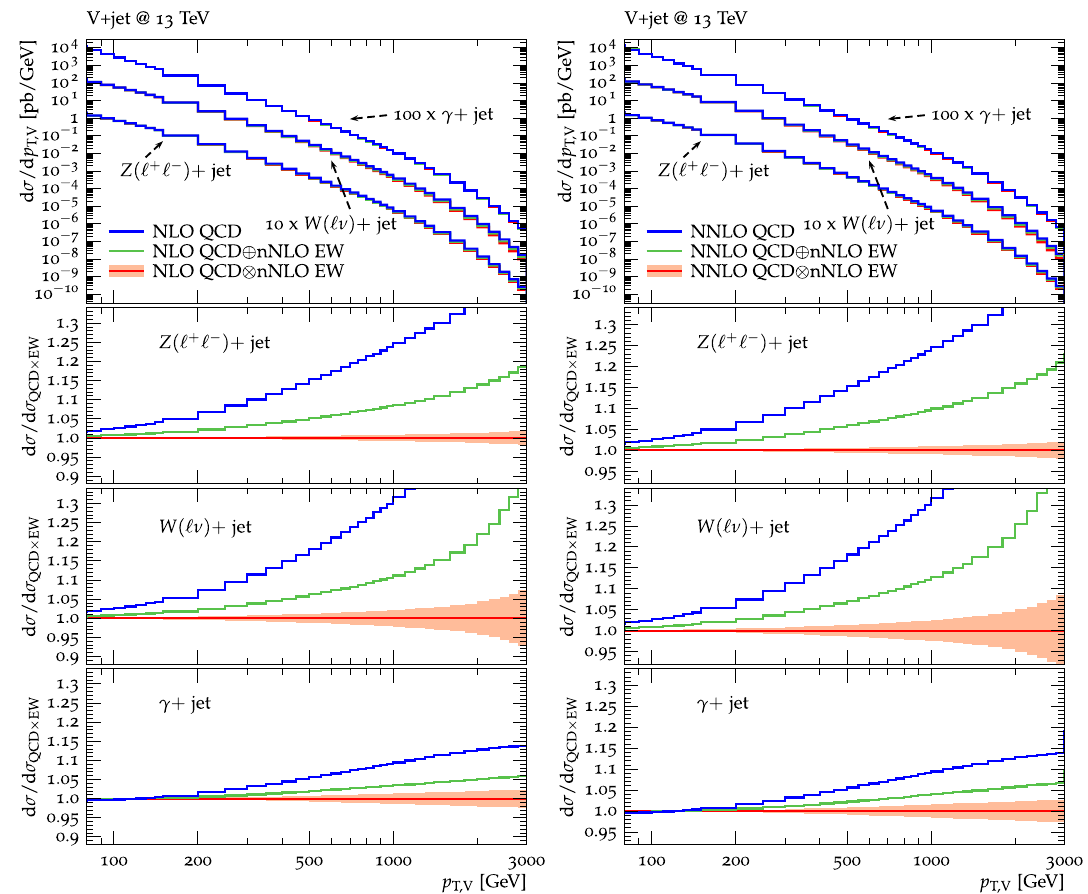
Fig. 16 Comparison of additive (green) and multiplicative (red) com- bination of (N)NLO QCD and nNLO EW corrections for various pp → V + jet processes at 13TeV. The red band corresponds to the